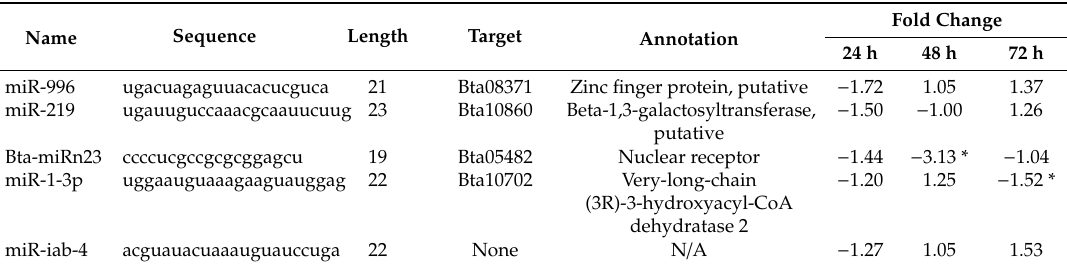
Table 3. MicroRNAs with fold change > 1.5 and reads per million (RPM) > 10 in whiteflies ( B. tabaci ) fed on TYLCV-infected tomato vs. uninfected